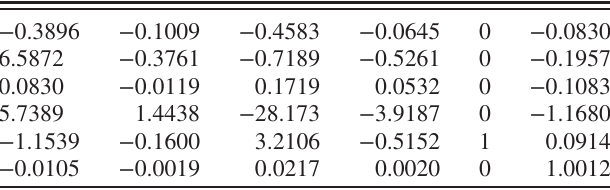
TABLE IV. Transfer matrix R of C2 ( j R j ¼ 1 . 02 ).